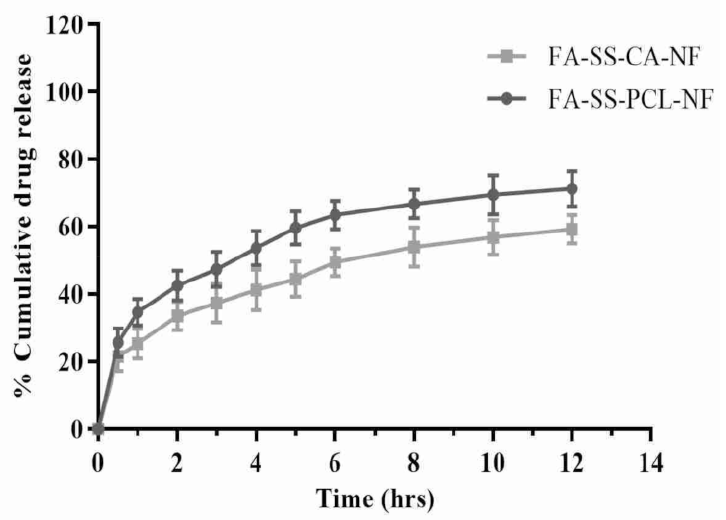
Figure 5. In vitro drug release of FA-SS-PCL-NF and FA-SS-CA-NF nanofibrous formulations in PBS at pH7.4 (mean ±